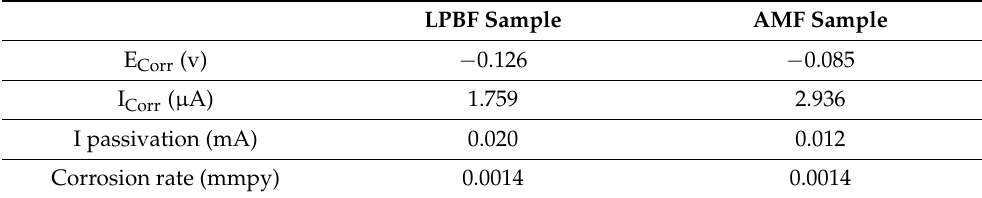
Figure 12. General appearance of localized corrosion attack: ( a , b ) HEA WTaMoNbV produced by LPBF process, ( c , d ) counterpart AMF alloy.